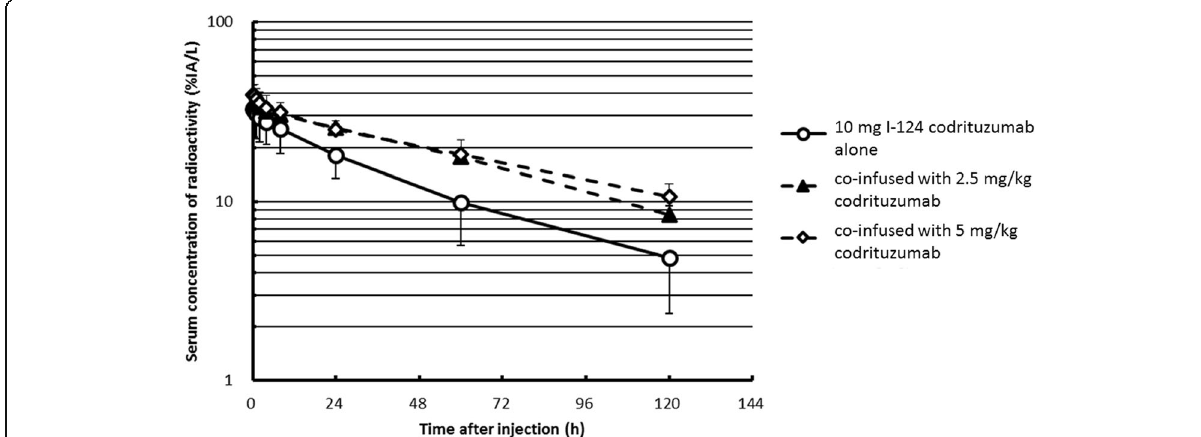
Fig. 5 %IA/L of serum was plotted following injection of 10 mg I-124 codrituzumab alone (circle) or co-infused with 2.5 mg/kg (triangles) or 5 mg/kg (squares). The larger mass amount of antibody resulted in significant mass-dependent changes with longer half-life and greater AUC than the 10 mg injection (Table 2). There was an overlap of the clearance curves for the 2.5 and 5 mg/kg co-infused